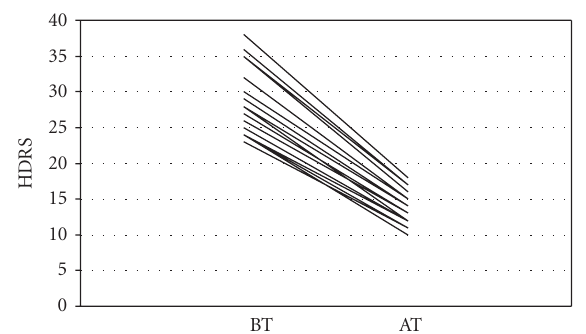
Figure 3: Interleukin-12 (IL-12) levels before (BT) and after (AT) sertraline